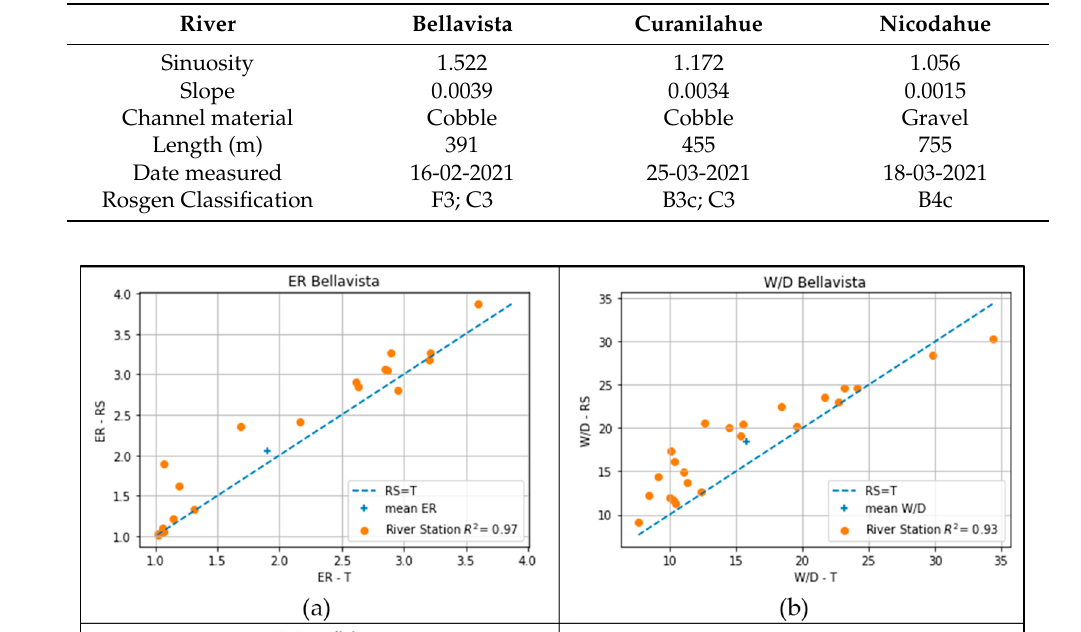
Table 2. Morphological characteristics of the studied river sections.